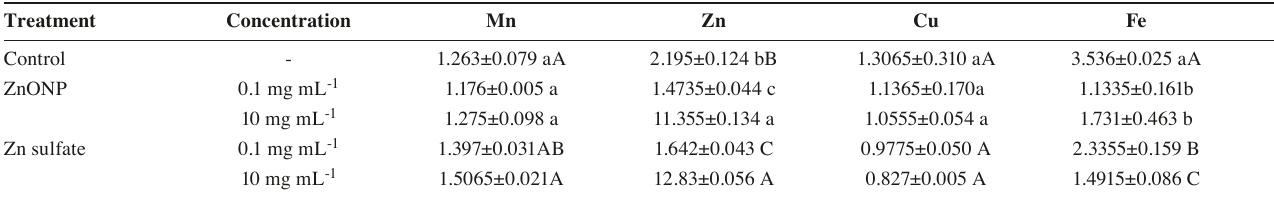
ANOVA: all differences are significant at